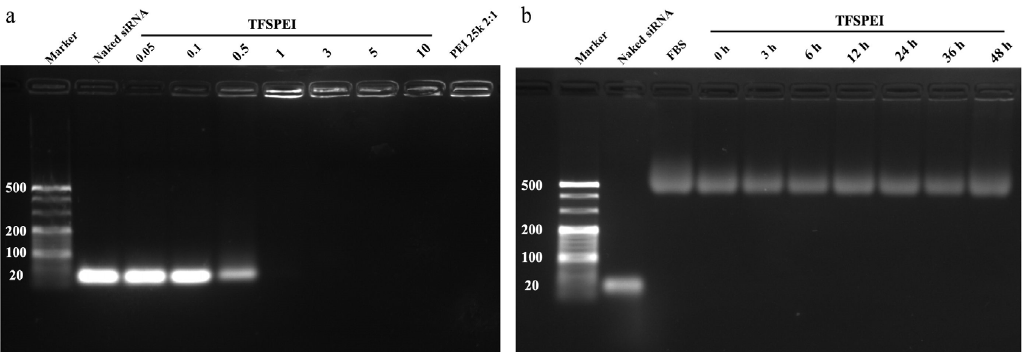
Figure 3. ( a ) AGE of the TFSPEI polyplex with different w/w ratios (0.05, 0.1, 0.5, 1, 3, 5, and 10) and ( b ) serum stability of the TFSPEI polyplex at the w/w ratio of 50 at different incubation times (0 h, 3 h, 6 h, 12 h, 24 h, 36 h, and 48 h).